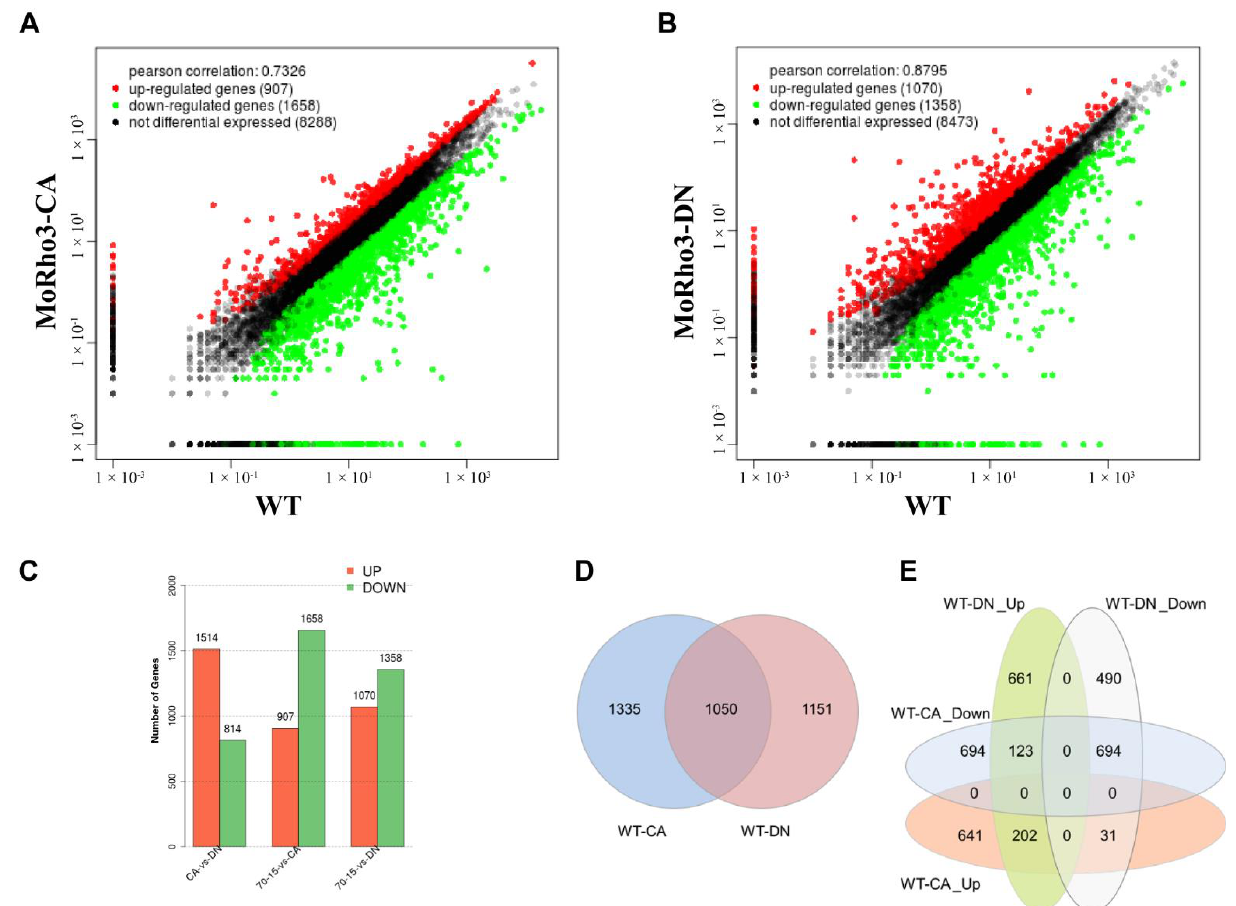
Figure 2. Comparison of DEGs in MoRho3 CA and DN mutants. Expression comparison between MoRho3-CA and WT ( A ) and MoRho3-DN and WT ( B ), red points represent up-regulated genes, and green points represent down-regulated genes. ( C ) The number of differentially expressed genes identified in MoRho3-CA vs. WT and MoRho3-DN vs. WT. ( D ) The intersection of all DEGs between